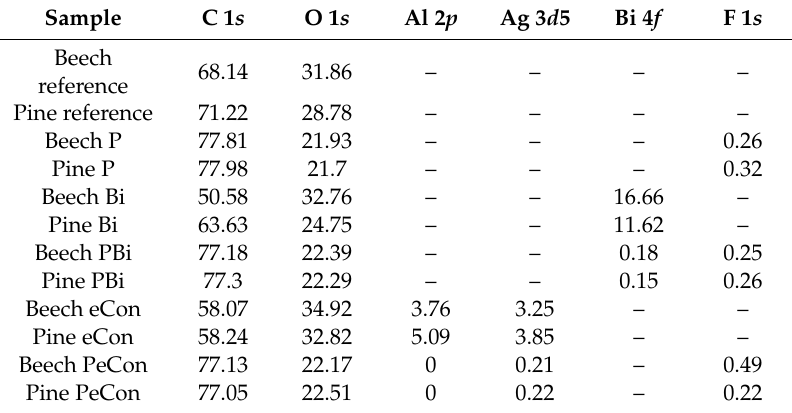
Table 2. Atomic concentration of reference and coatings in atom—%.